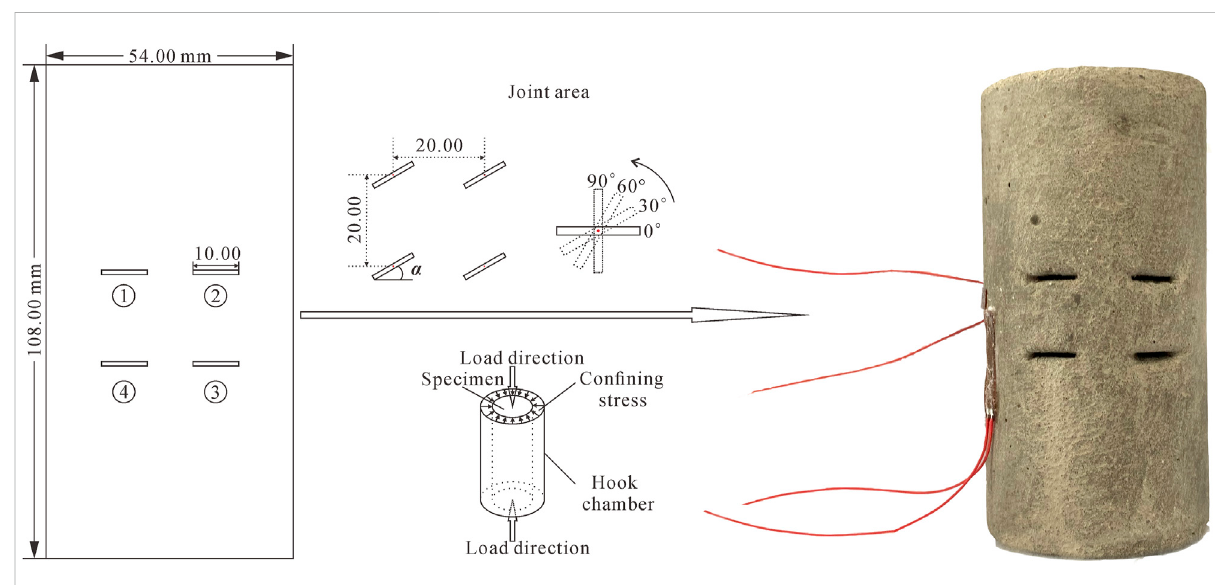
FIGURE 1 Detailed information of the specimen containing four fl aws from plane